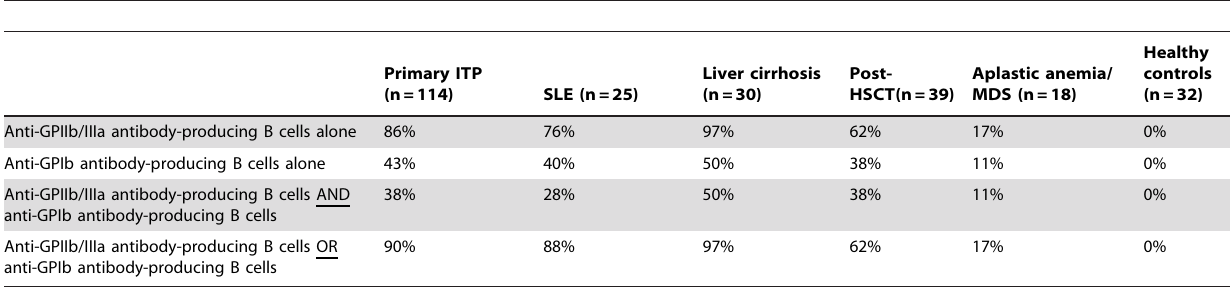
Table 2. Positive frequencies of circulating anti-GPIIb/IIIa and anti-GPIb antibody-producing B cells, and their combination in patients with primary ITP, various thrombocytopenic conditions, and healthy